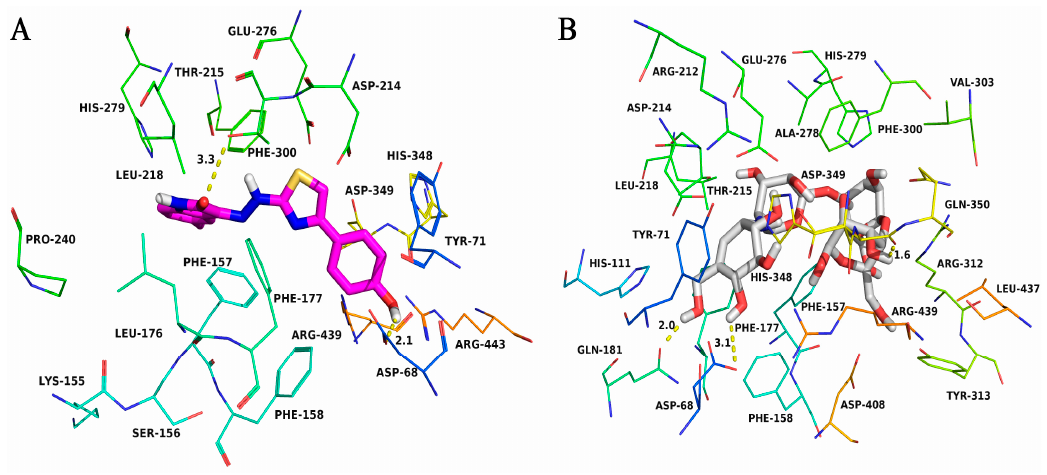
Figure 2. Compound 6i ( A ) and acarbose ( B ) was docked to the binding pocket of the Saccharomyces cerevisiae α -glucosidase.